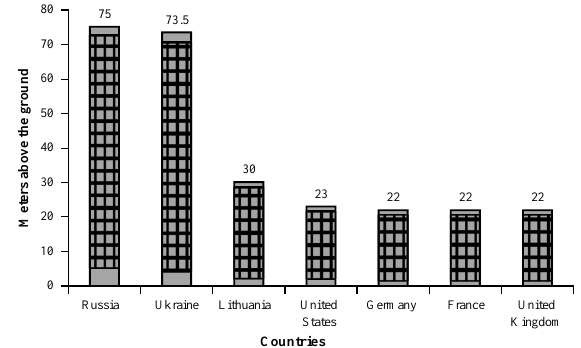
Fig. 1. Different definition of a high-rise